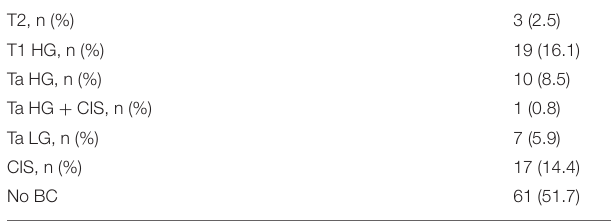
TABLE 1 | Results of Re-TUR in completely resected high grade T1 BC.